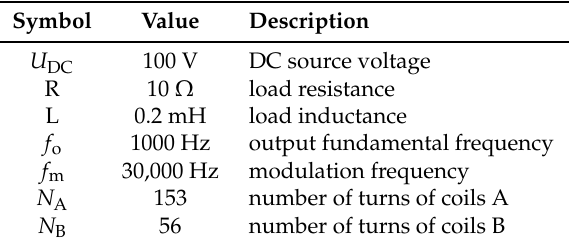
Table 2. Circuit and modulation parameters used in simulation.